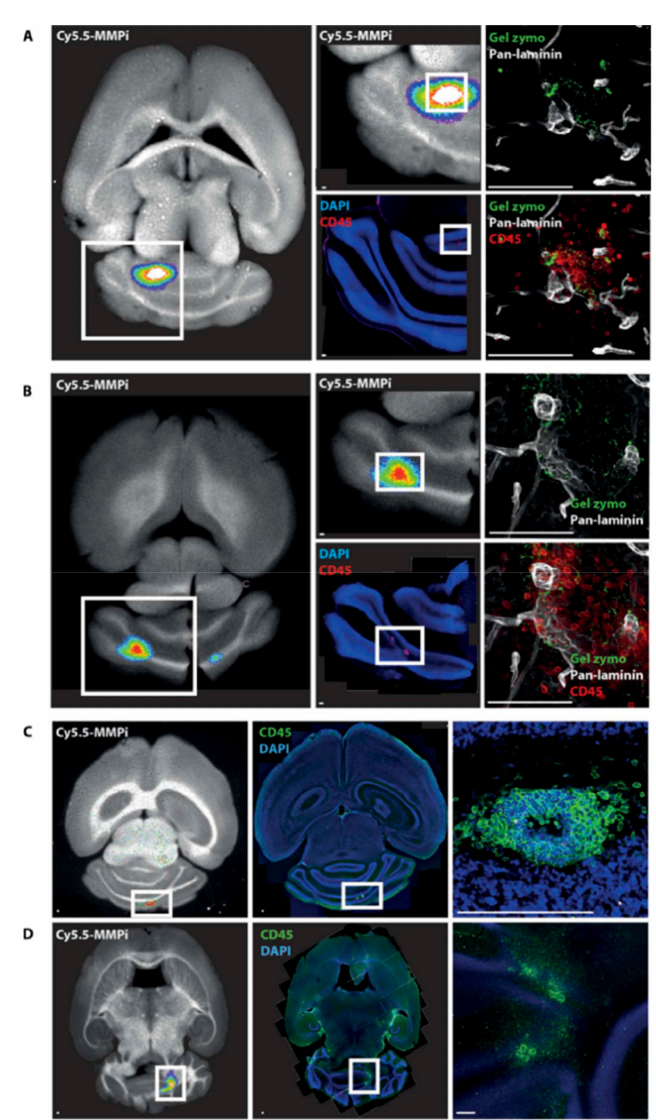
Figure 8. Cy5.5-MMPI 21 tracer signal localizes at sites of perivascular cuffs and gelatinase activity in vivo. ( A , B ) Five hours after intravenous injection of 21 (4 nmol) in two score 3 EAE mice, the brains were sliced into thick sections (200 mm) and imaged by FRI; color-encoded near infrared fluorescence and white-light images were captured and matched (left images). The same brain slices were then analyzed by in situ zymography for detection of activated gelatinases and subsequently stained with pan-laminin to define vessel borders and with CD45 antibodies to visualize inflammatory infiltrates (right images). Scale bars, 100 mm. ( C , D ) FRI of thick EAE brain sections (200 mm) at 5 h after intravenous injection of (4 nmol). Overlay of color-encoded near-infrared fluorescence image with significant MMP activity (red) projected onto the white-light image. The same brain slice was subsequently immunofluorescently stained with CD45 antibody; blue signal. 4 (cid:48) ,6-diamidino-2- phenylindole (DAPI) staining of nuclei. Two separate brains are shown in ( C , D ). Scale bars, 100 mm. Reprinted with permission from [103] Copyright © 2016, American Association for the Advancement of